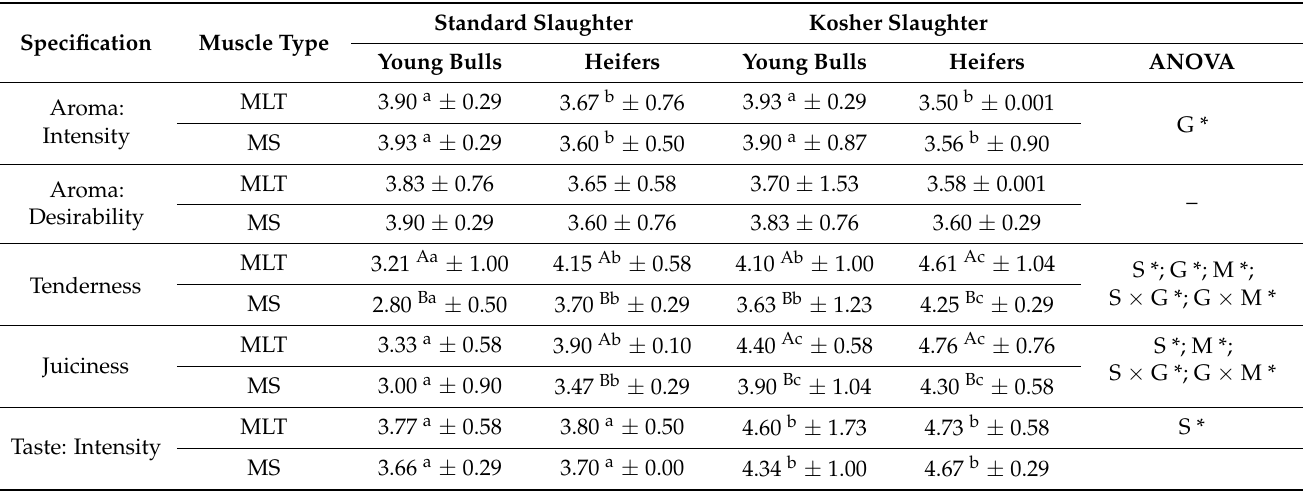
Table 3. Sensory properties of beef ( x ± SE) depending on slaughter type, muscle type, and